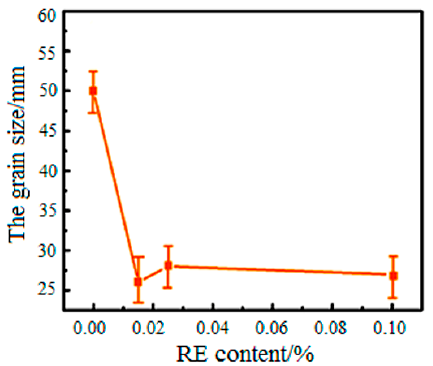
Figure 6. Variation of average grain sizes of as-cast H13 steel with additions of RE, reproduced from Reference [30], with permission of Springer, 2015.